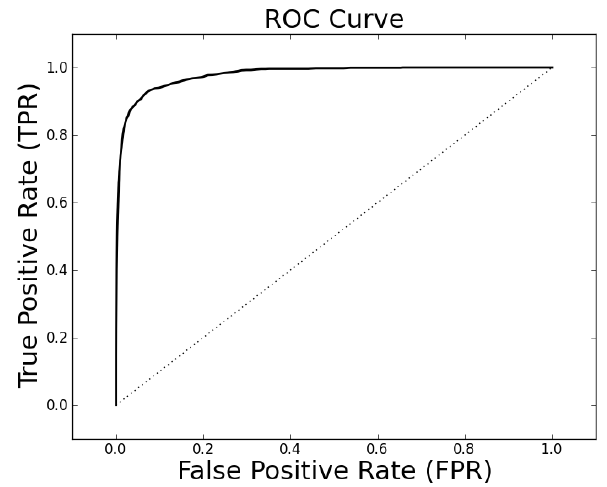
Figure 4. The receiver operating characteristic (ROC) curve for the entire Proteus300 dataset = 0 . 5 and ρ = 0 . 3 with κ = 19 , ρ o c